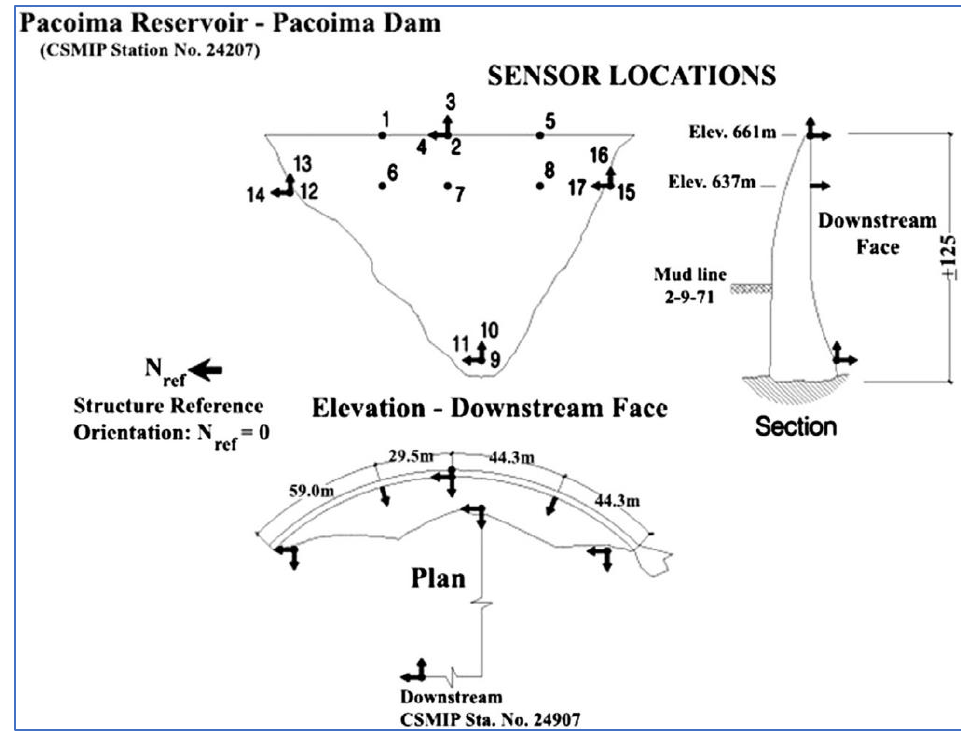
Figure 3. Pacoima arch dam and the layout of the acceleration sensors (http://www.strongmotioncenter.org/NCESMD/photos/CGS/lllayouts/ll24207.gif) (accessed on 1 July 2021).